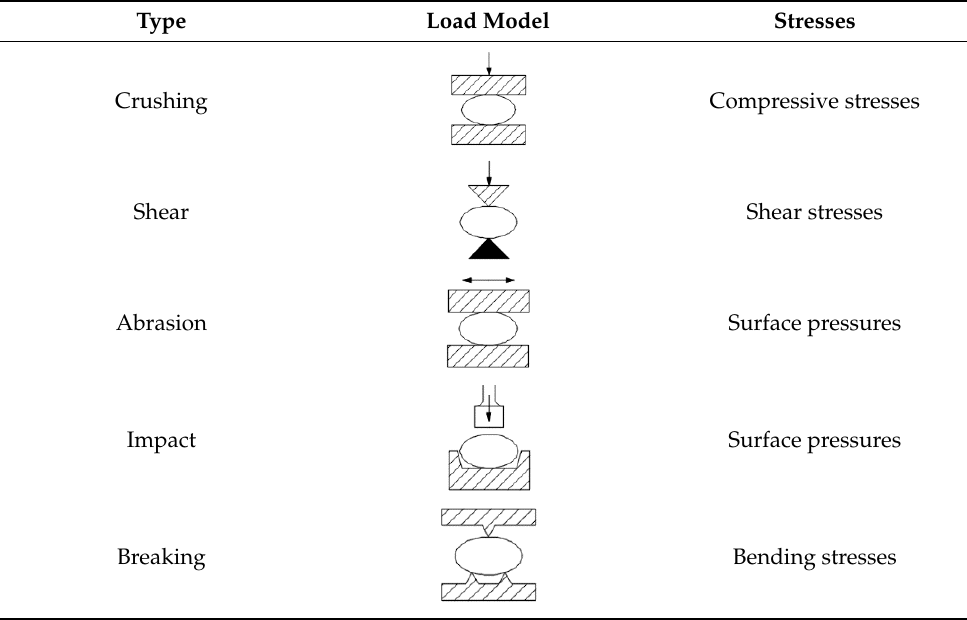
Table 2. Shredding types (methods) according to [36,99–101].